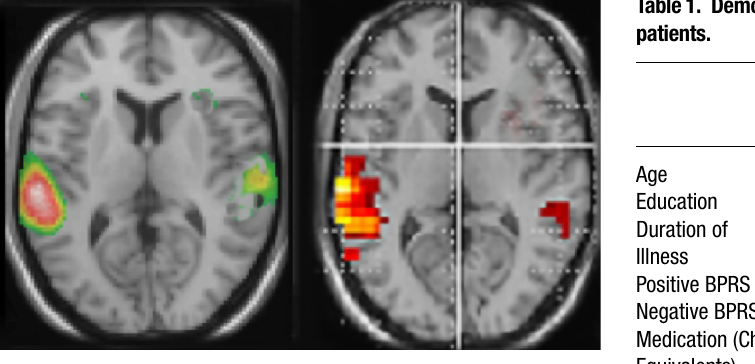
Figure 1. Functional brain activation data when healthy subjects listen to dichotic presentations of consonant–vowel syllables. Note the marked left hemisphere lateralization in both data sets. The left-hand panel shows PET-data (from Hugdahl et al., 1999 ), the right-hand panel shows corre- sponding fMRI-data (unpublished data Bergen fMRI-group). Both data sets were evaluated with a statistical signifi cance threshold at p < 0.001 (uncor- rected). Neurological left-right display conventions.